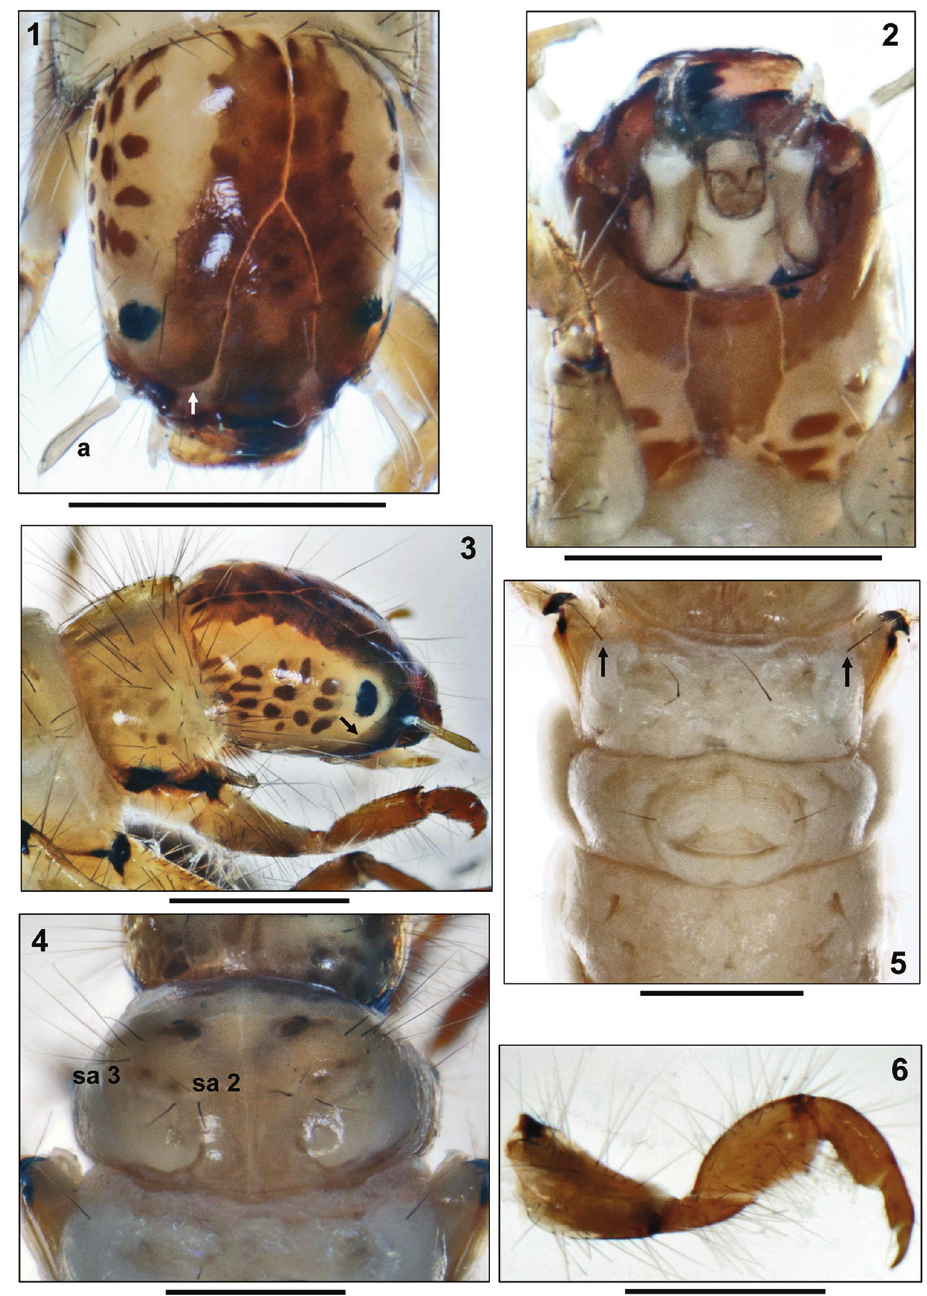
Figures 1–6. Adicella syriaca Ulmer 1907, final instar larva. 1 Head, dorsal view (a= antenna; arrow= subocular ecdysial line) 2 Head, ventral view 3 Head and pronotum, right lateral view (arrow= subocular ecdysial line) 4 Mesonotum, dorsal view (sa2, sa3= setal areas 2 and 3) 5 Metathorax and abdominal segments I and II, dorsal (arrows = single seta of sa3) 6 Right foreleg, posterior face. Scale bars: 0.5